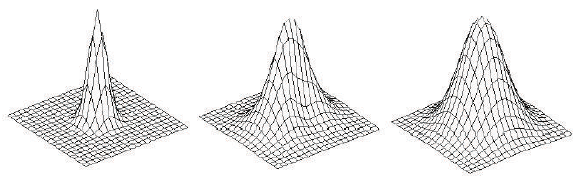
Figure 3: Left : A small isotropic lowpass filter can be used by CCA by setting the weights of all the other filters to zero. Middle : anisotropic lowpass filters with arbitrary orientation can be created by CCA by first combining the anisotropic filters and then adding the small lowpass filter. Right : by using the same weight for all the filters, a large isotropic lowpass filter can be